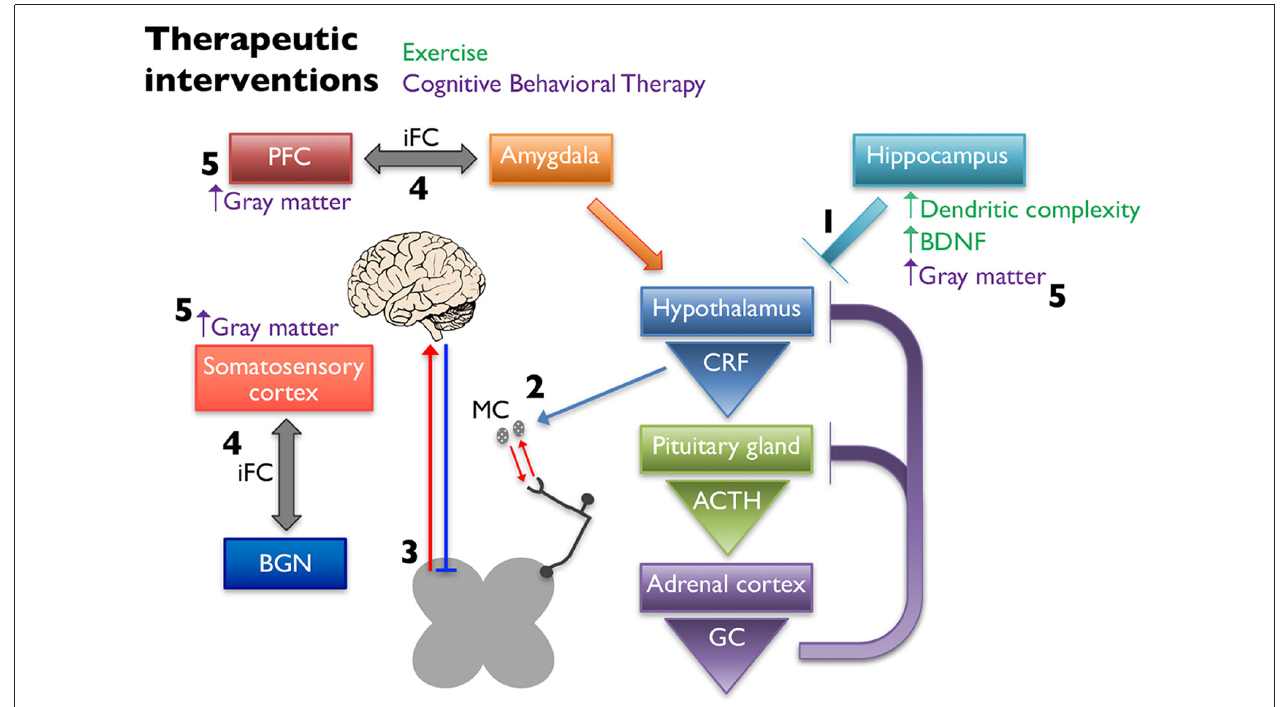
FIGURE 3 | Non-pharmaceutical interventions restore proper signaling within the HPA axis and between higher structures. Exercise increases dendritic complexity and BDNF expression in the hippocampus, which restores negative input onto the hypothalamus to restore proper HPA axis output (1). Decreased CRF release stabilizes MC activation and infiltration associated with chronic pain disorders (2), thereby reducing peripheral nociceptive input. Exercise influences the descending pain pathway, likely through release of endogenous opioids, increasing neuronal activity, and balancing excitatory and inhibitory transmission (3). Cognitive behavioral therapy (CBT) alters the intrinsic functional connectivity (iFC) between brain regions associated with pain management, including connections between the prefontal cortex (PFC) and amygdala and somatosensory cortex and the basal ganglia network (BGN) (4). Cortical and hippocampal gray matter densities are also increased in patients following CBT